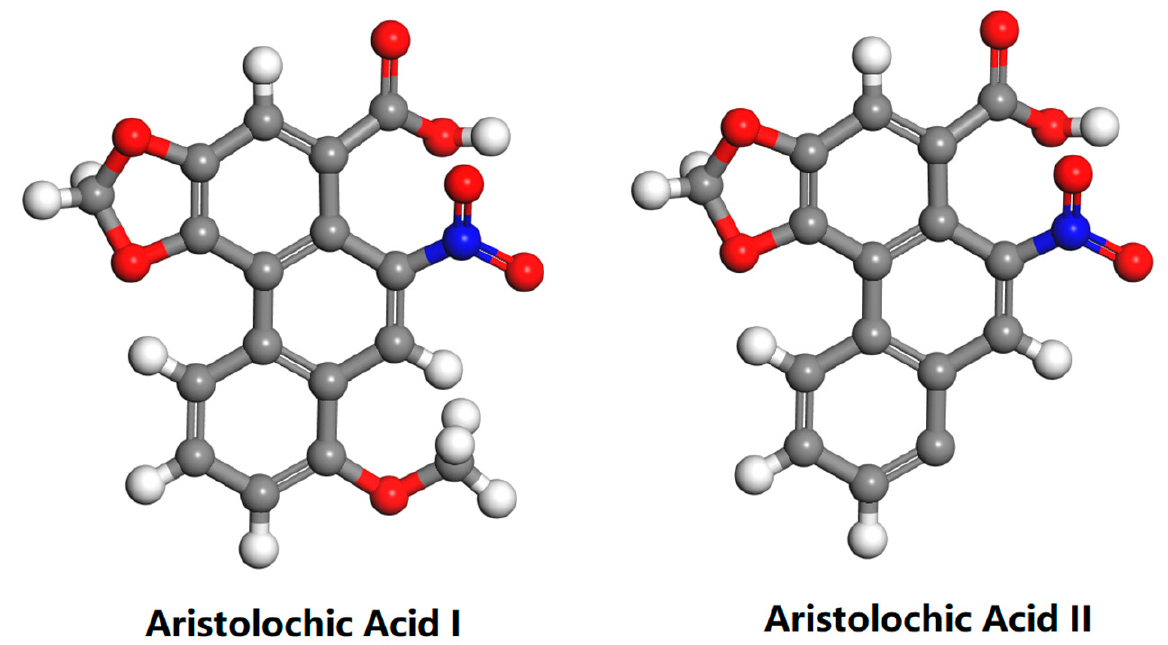
Figure 1. Chemical Structures of Aristolochic Acid I and Aristolochic Acid II. Plants containing aristolochic acid are widely distributed [29,30]. However, the route by which AAs enter the food chain has not been fully defined [13]. The